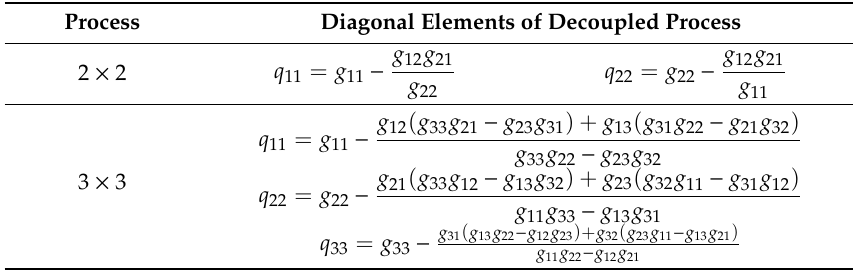
Table 2. The diagonal elements of the decoupled matrix for 2 × 2 and 3 × 3 processes.